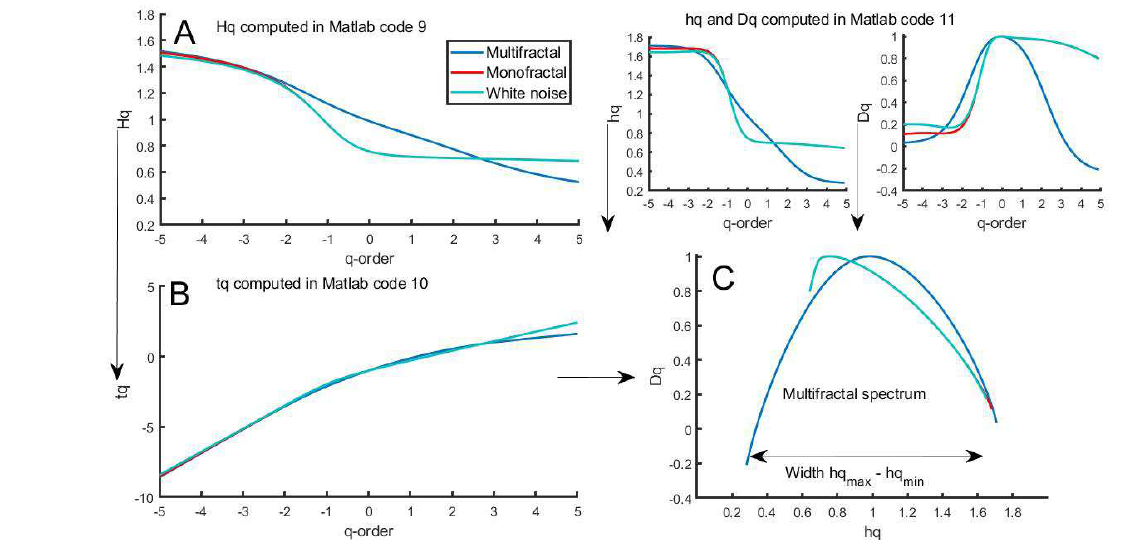
Figure 7. The multifractal spectrum of time